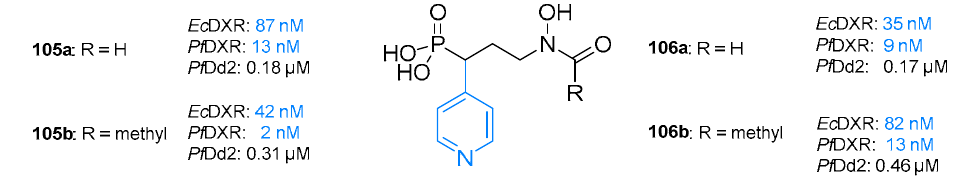
Figure 21. Biological data of structurally diverse α -substituted analogs 97 – 104 .